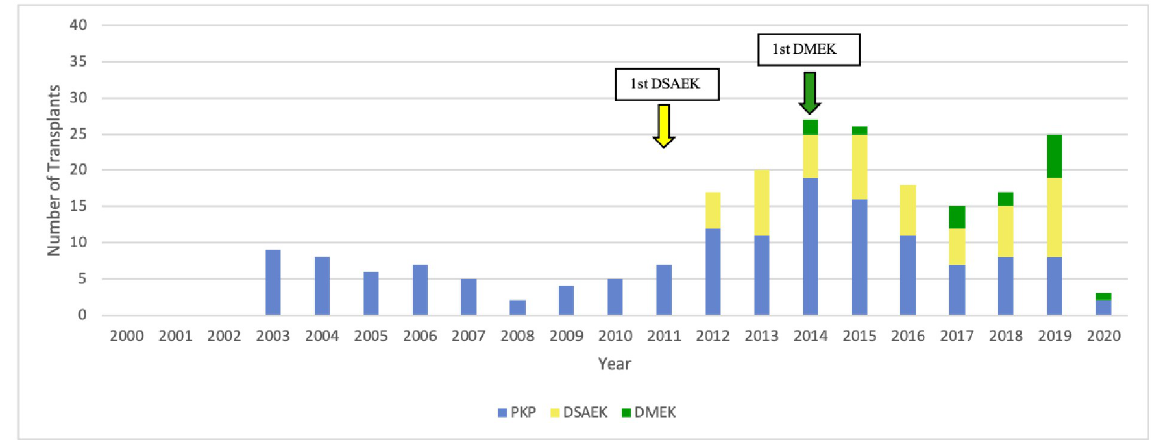
Fig 6. Changes over time in the type of surgery used for regrafts. DSAEK, Descemet stripping automated endothelial keratoplasty; DMEK, Descemet membrane endothelial keratoplasty; PKP, penetrating keratoplasty.